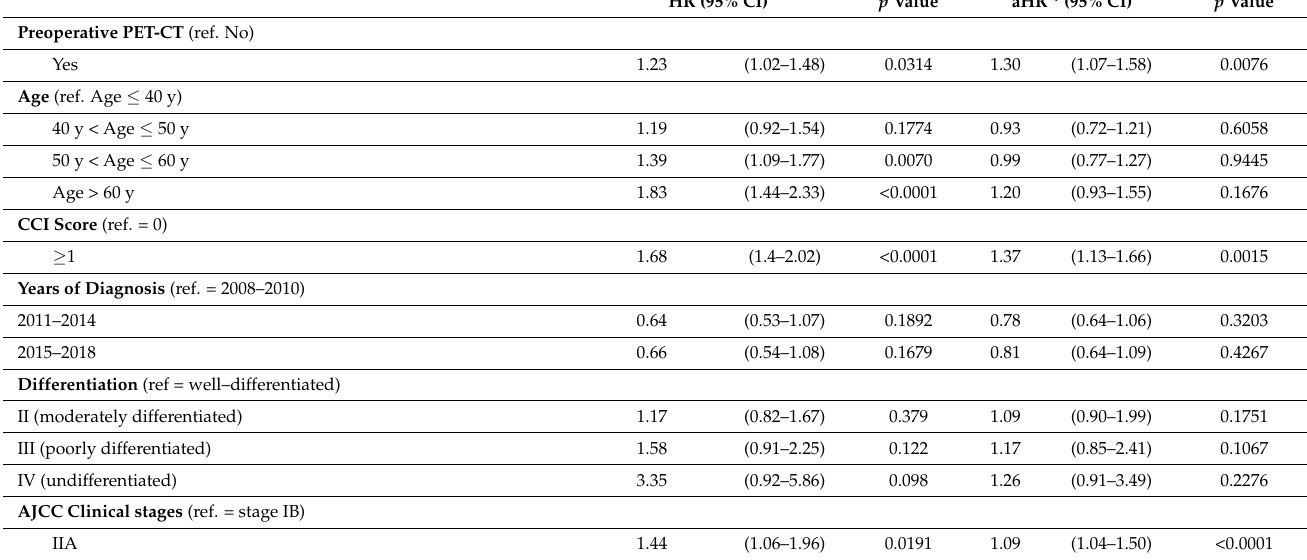
Table 2. Cox-proportional-hazards regression analysis of the risk of all-cause death among propensity score–matched patients with cervical cancer receiving curative